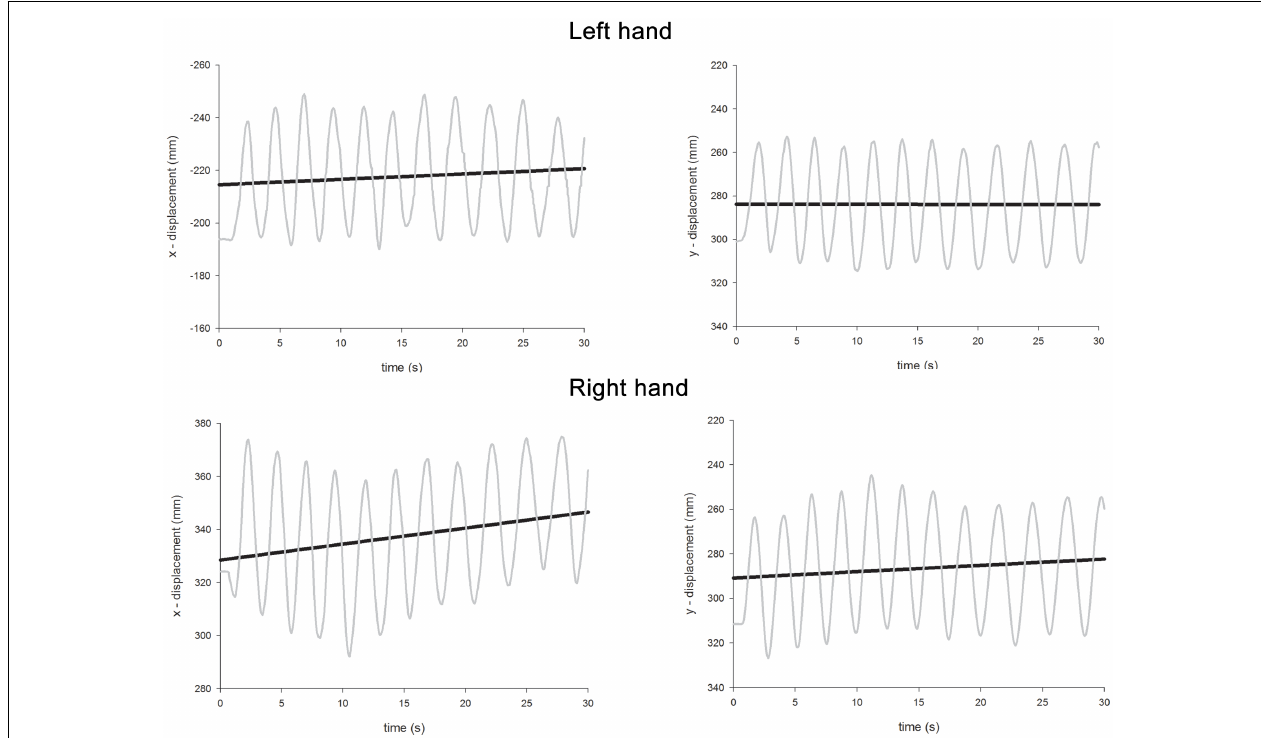
FIGURE 7 | Representative linear regression slopes for the x - and y -axes in the bimanual movement conditions when gaze was directed leftwards in Experiment 2